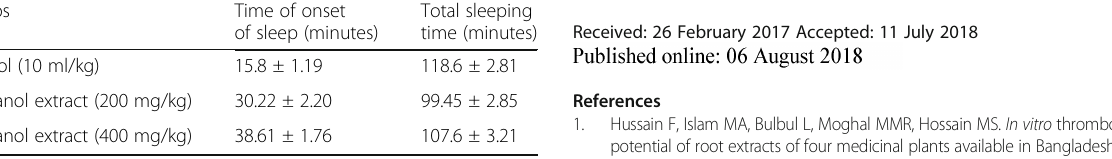
Table 9 Effect of L. speciosa flower extract on phenobarbitone sodium – induced sleep